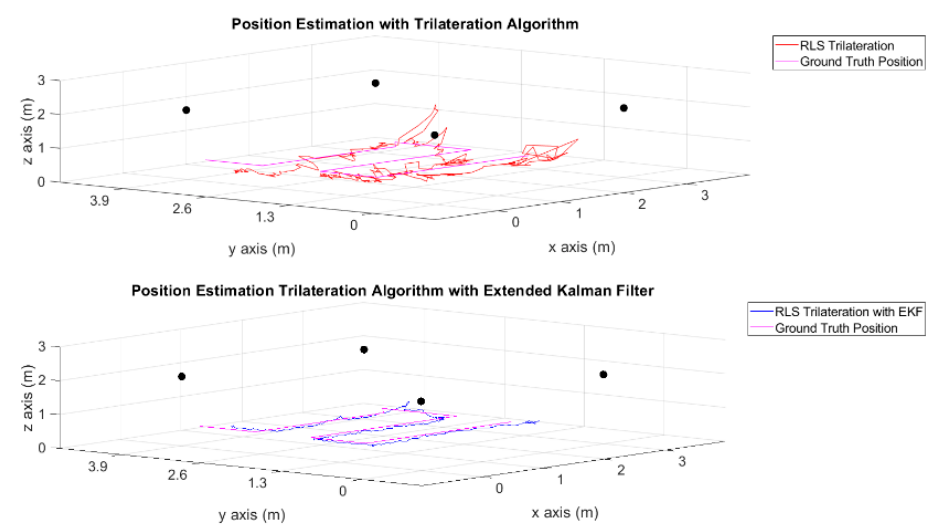
Figure 3. Position Estimation in Path 1 Trilateration Algorithm with and without EKF.